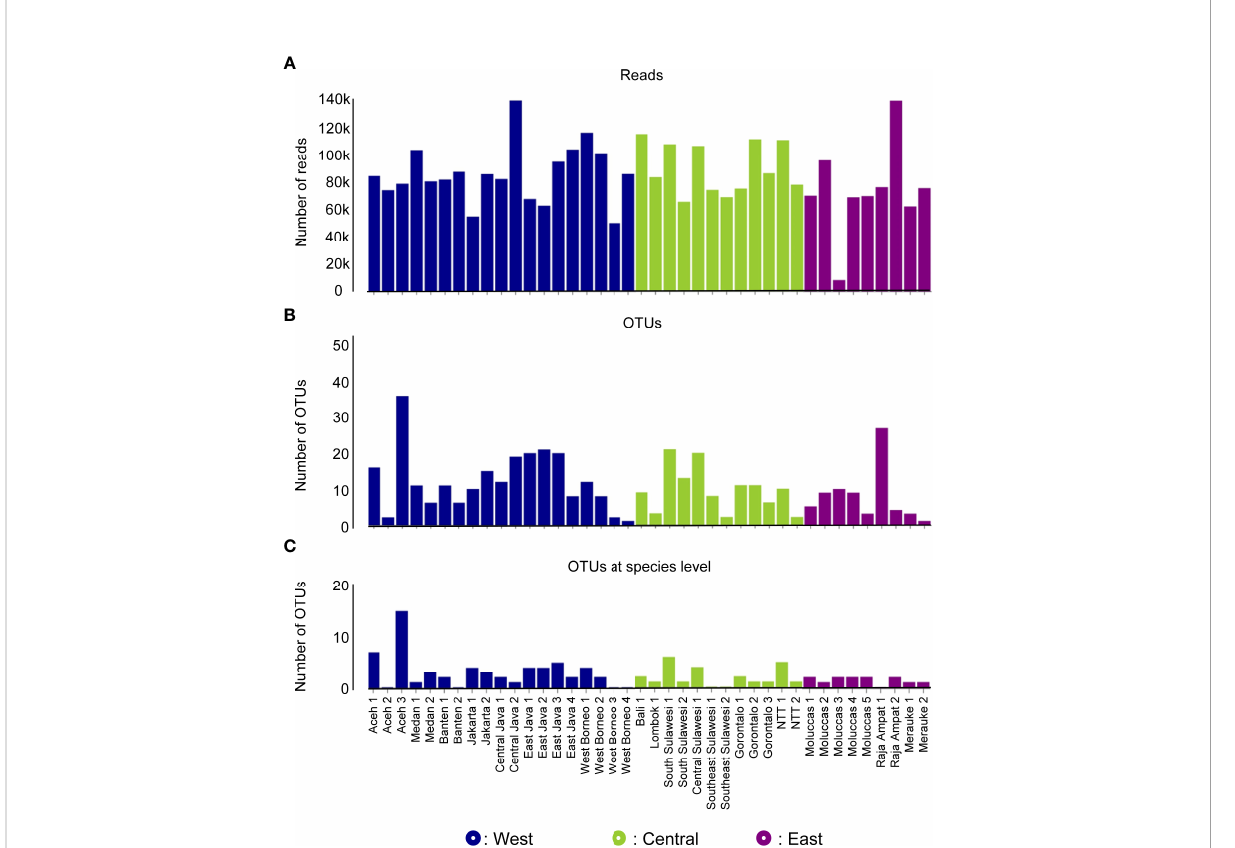
FIGURE 2 eDNA sequence data obtained by sampling site and region: number of reads (A) , number of Operational Taxonomic Units (OTUs) (B) , and OTUs identi fi ed to species level (C)